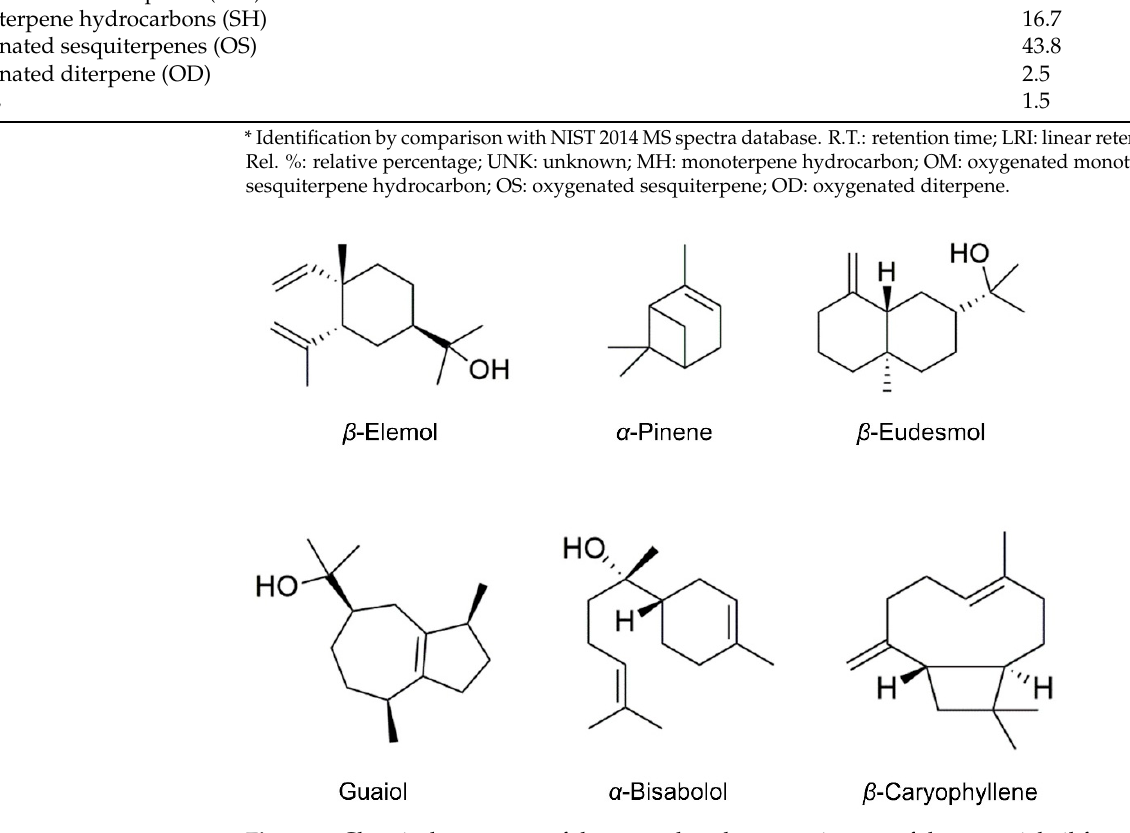
Figure 2. Chemical structures of the most abundant constituents of the essential oil from the aerial parts of Tunisian Teucrium luteum subsp. flavovirens . Table 1. Volatile compounds identified in the essential oil from the aerial parts of Teucrium luteum subsp. flavovirens growing wild in Tunisia. The most abundant constituents are reported in bold, and their structures are shown in Figure 2.